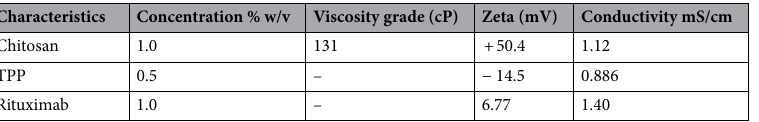
Table 1. Physical characterization of polymer, cross linker and monoclonal antibody. TPP tripolyphosphate, cP centipoise, mV milli voltage, mS/cm milli Siemens per centimetre.